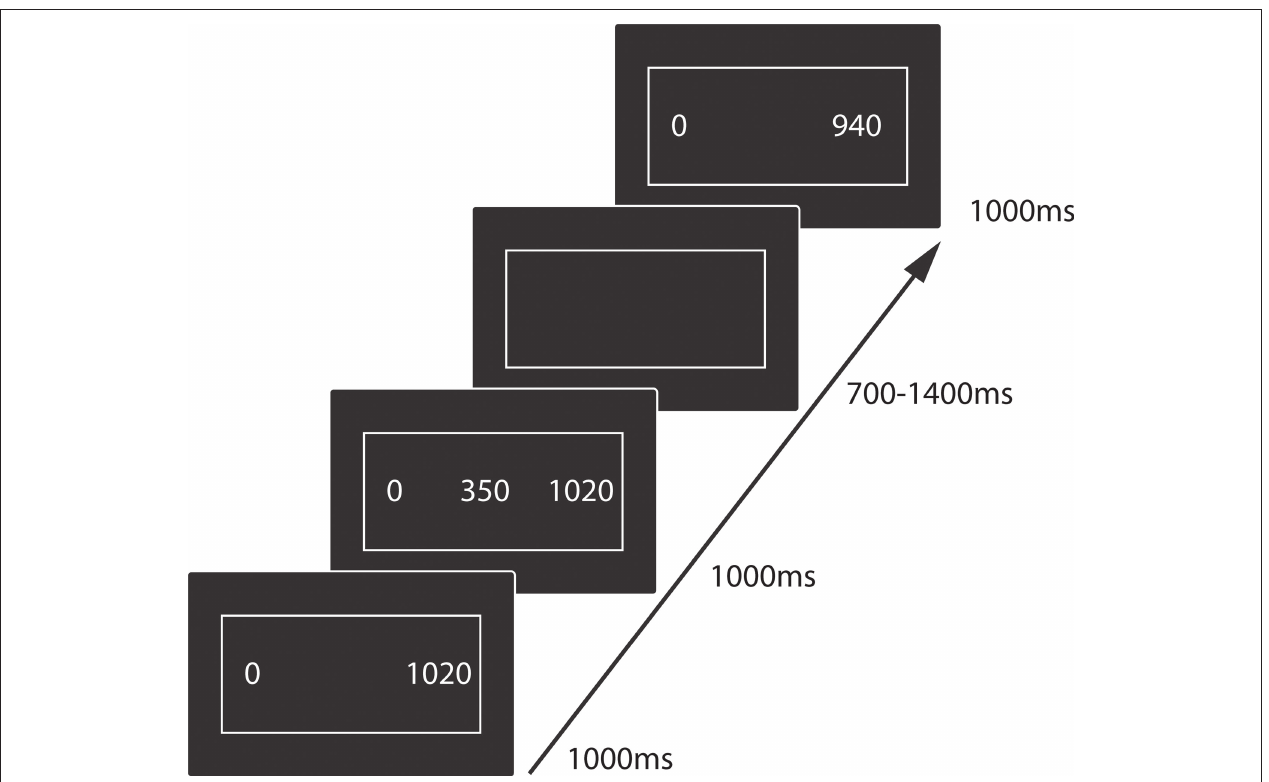
FIGURE 3 | Experimental